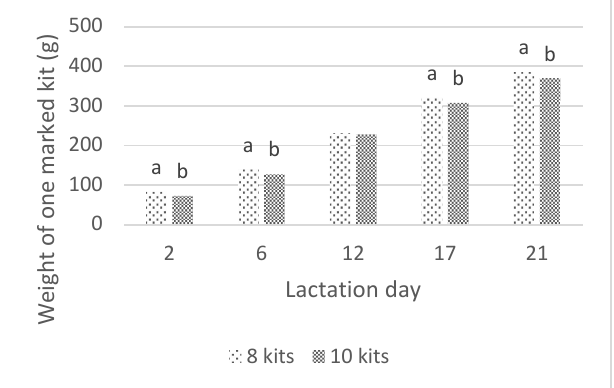
Figure 2. The effect of litter size on the weight of one marked kit (a, b—means marked with different letters differ significantly at p < 0.05).